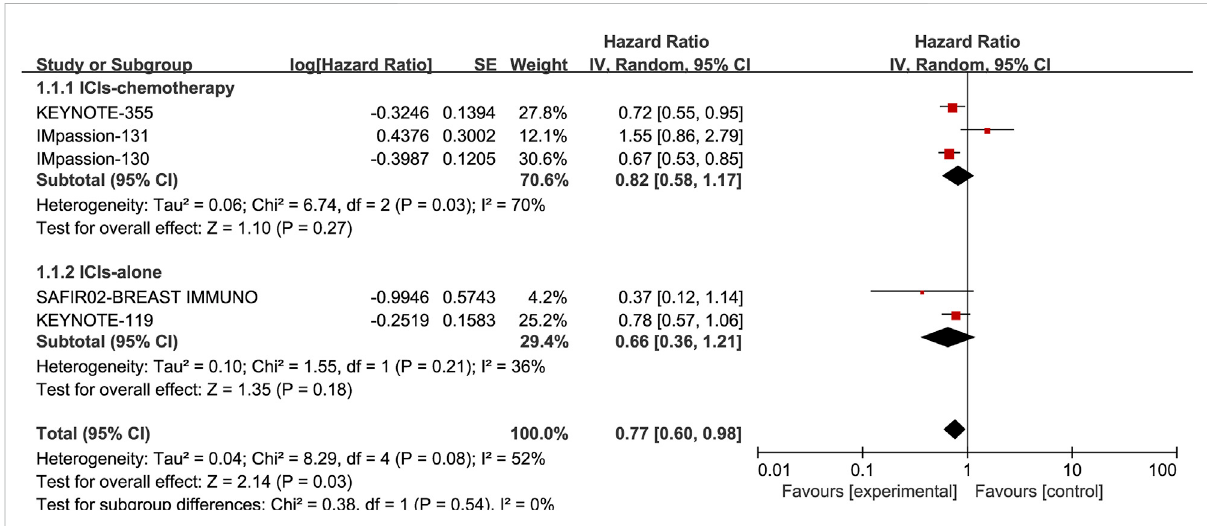
FIGURE 5 Subgroup analysis of the effect of ICIs combined with chemotherapy or not on OS in PD-L1 positive TNBC patients.